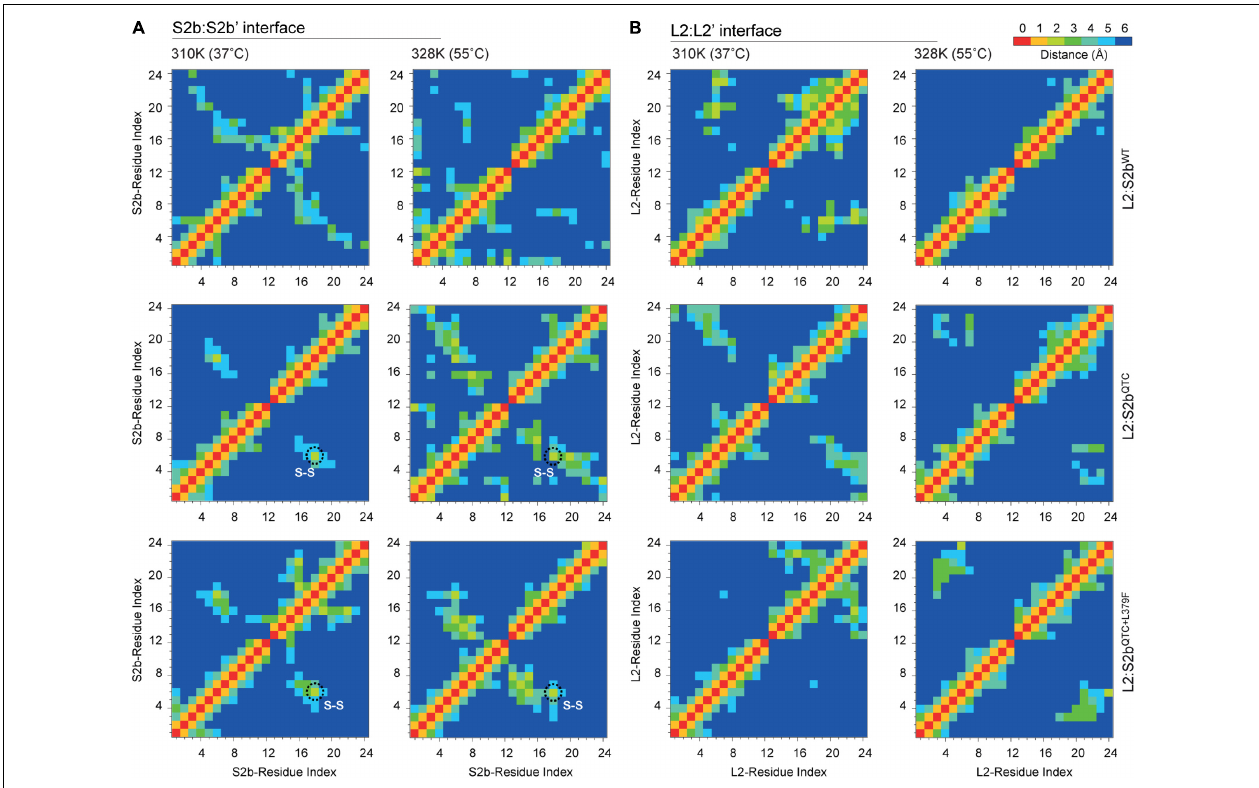
FIGURE 7 | The cross correlation matrix representing the residue pair contact maps between N-terminal loops of (A) S2b:S2b (cid:48) and (B) L2:L2 (cid:48) interfaces of L2/S2b WT , L2/S2b QTC , and L2/S2b QTC + L379F complexes at 37 and 55 ◦ C. The black dotted circle indicates the Cys–Cys disulfide bonds.